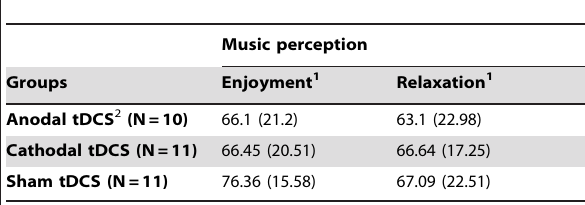
Table 2. Subjective music perception.